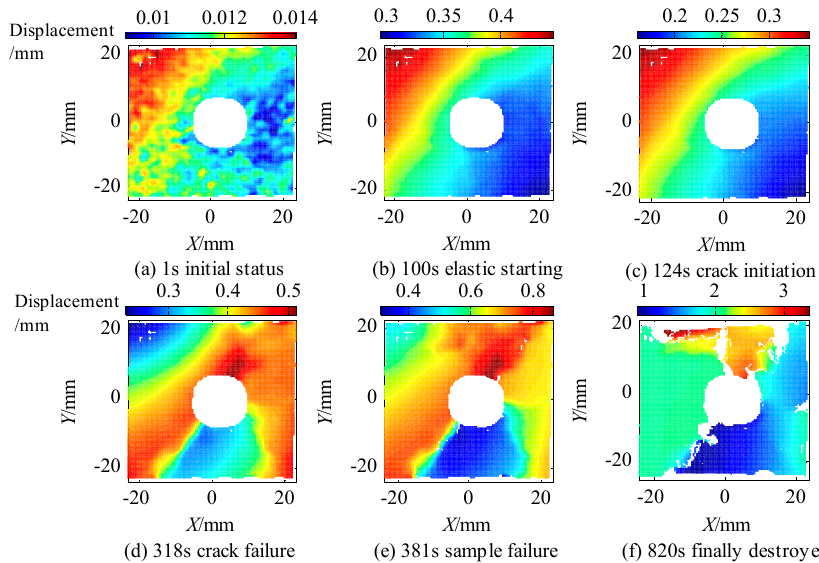
Figure 5. Revolution of displacement field.